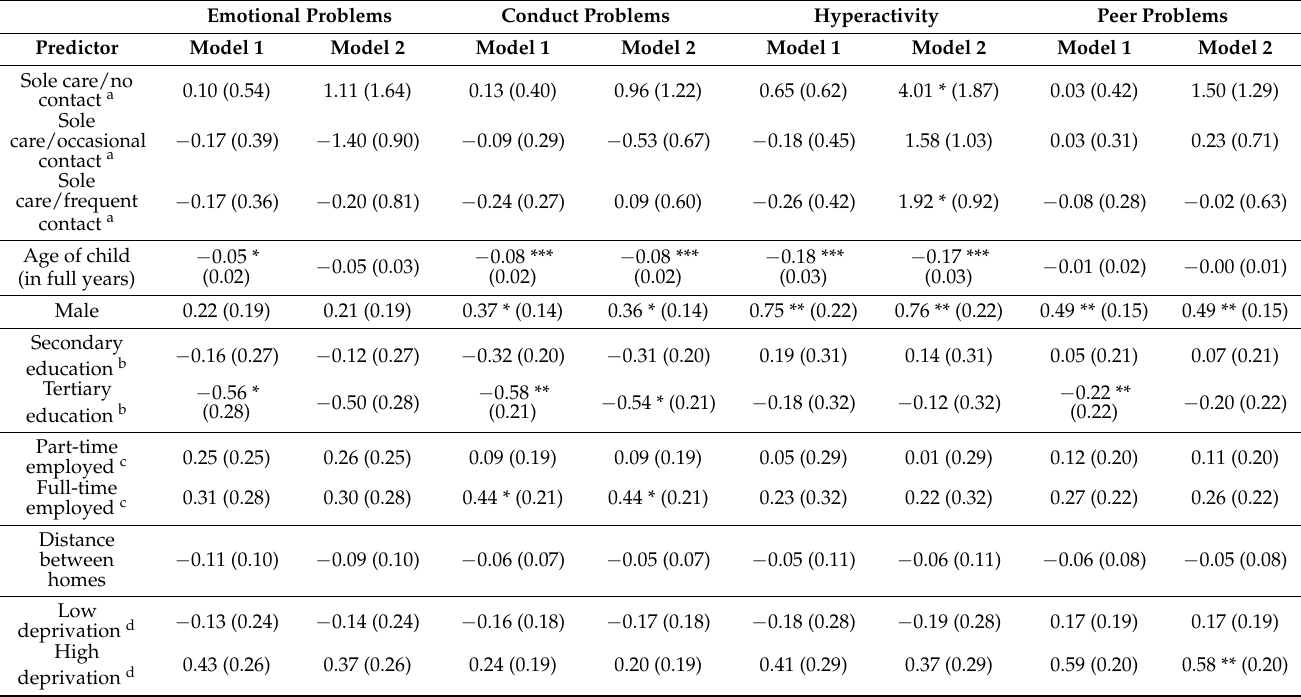
Table 1. Stepwise OLS regression models predicting the SDQ subscales (one model each; higher values indicate worse child adjustment; Model 1 = main effect model; Model 2 = with interactions between post-separation physical custody arrangements and the quality of the parental coparenting relationship, N =